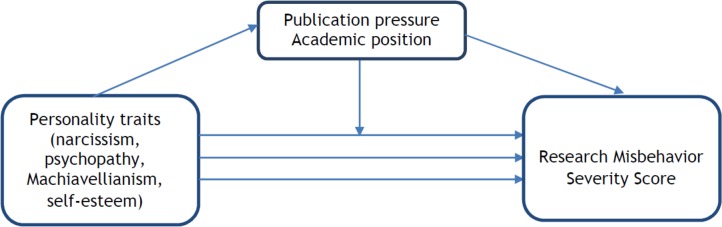
Predefined analysis model.